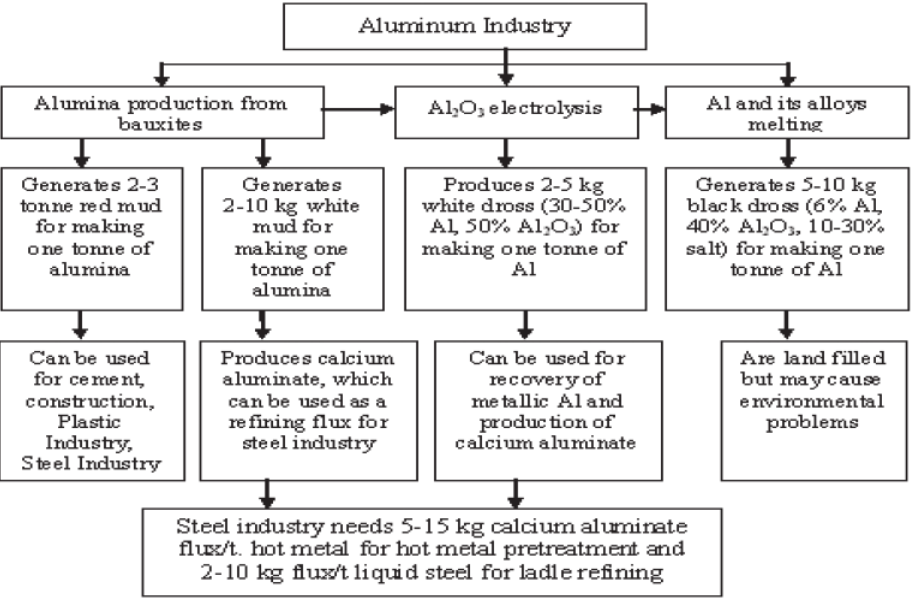
Fig. 1: Sources of waste residues from the aluminum industry and their potential